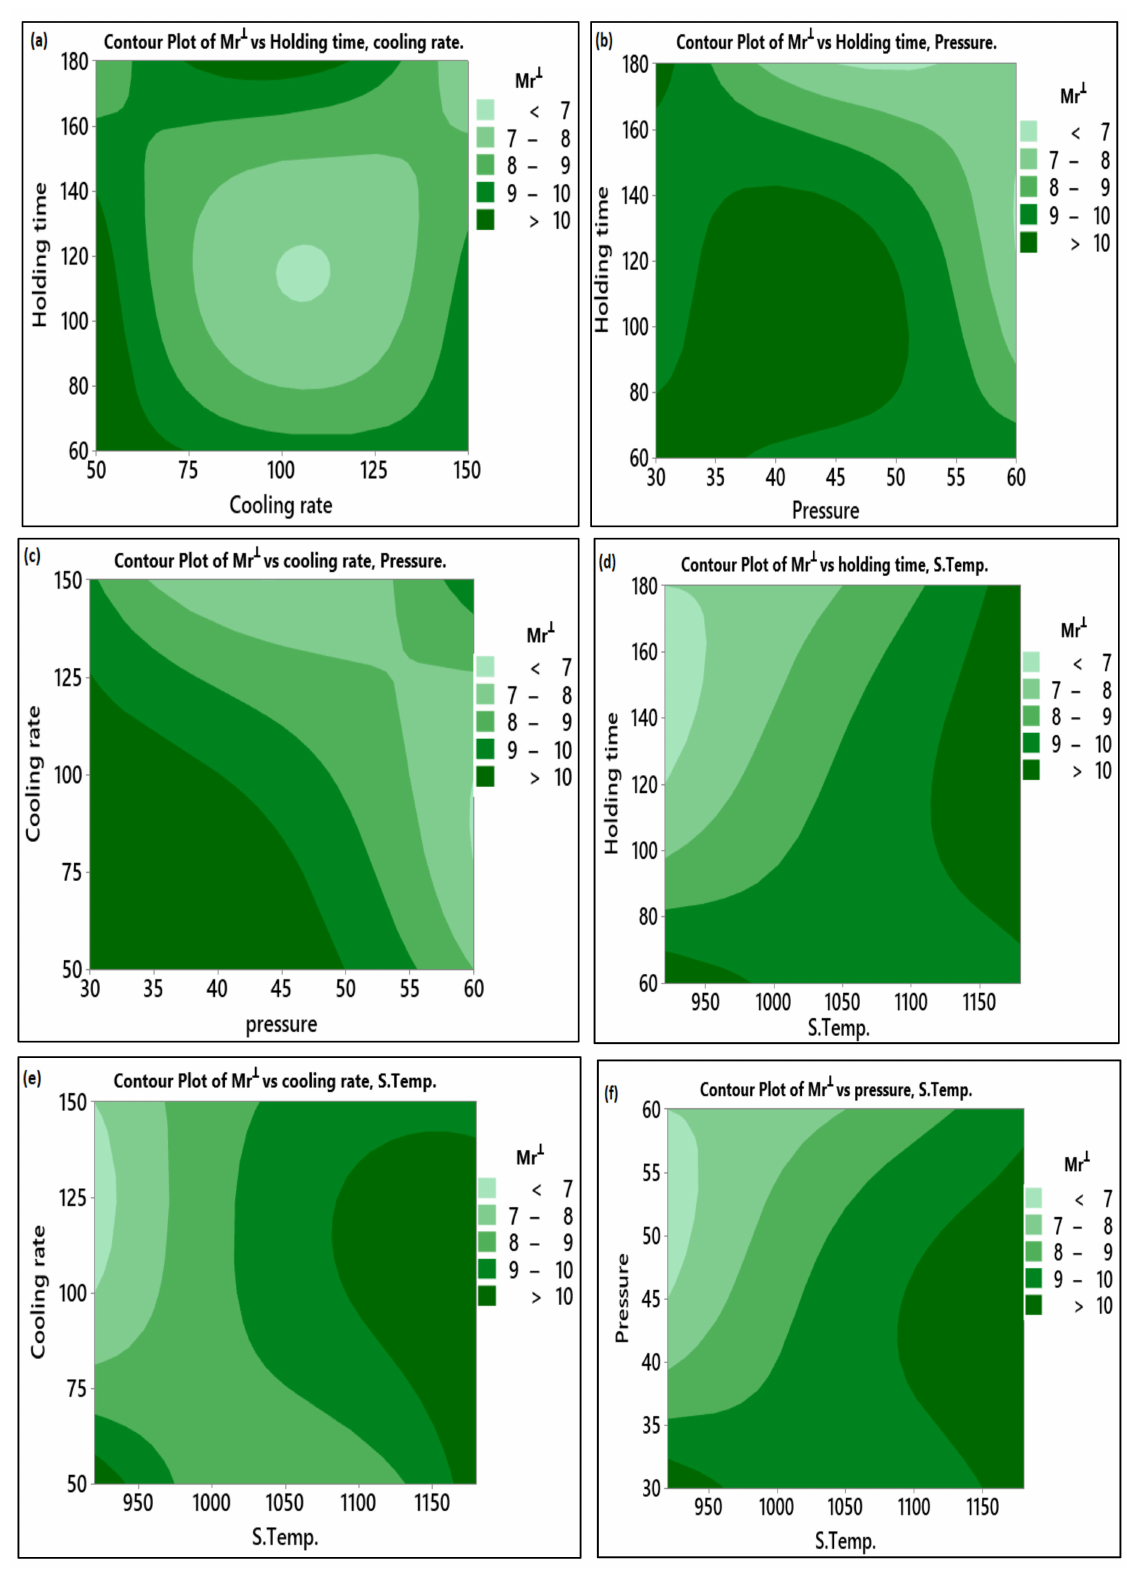
Figure 11. Contour plot for Mr ⊥ : ( a ) Holding time vs. cooling rate; ( b ) Holding time vs. pressure; ( c ) Cooling rate vs. pressure; ( d ) Holding time vs. S. temp.; ( e ) Cooling rate vs. S. temp.; ( f ) Pressure vs. S.